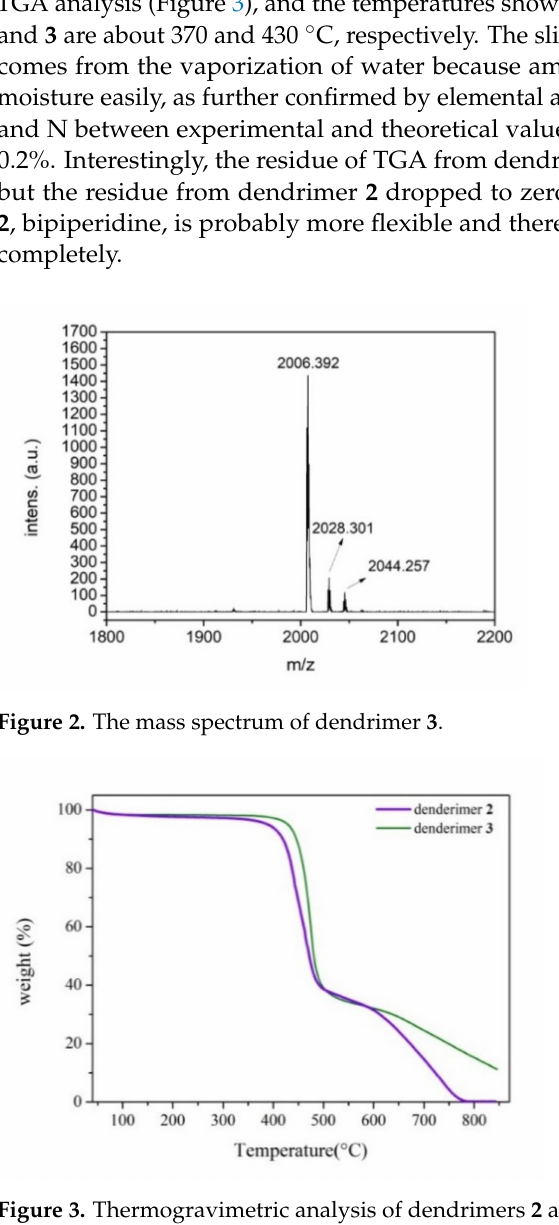
Figure 3. Thermogravimetric analysis of dendrimers 2 and 3 from 30 to 850 ◦ C at a heating rate of 10 ◦ C min − 1 under an N 2